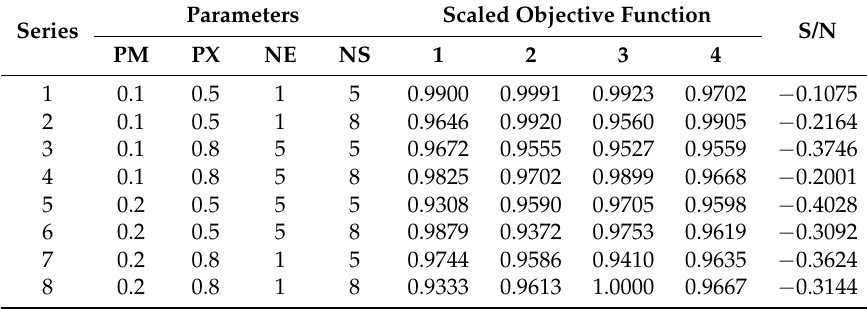
Table 3. Scaled outputs for the first stage according to L8 orthogonal